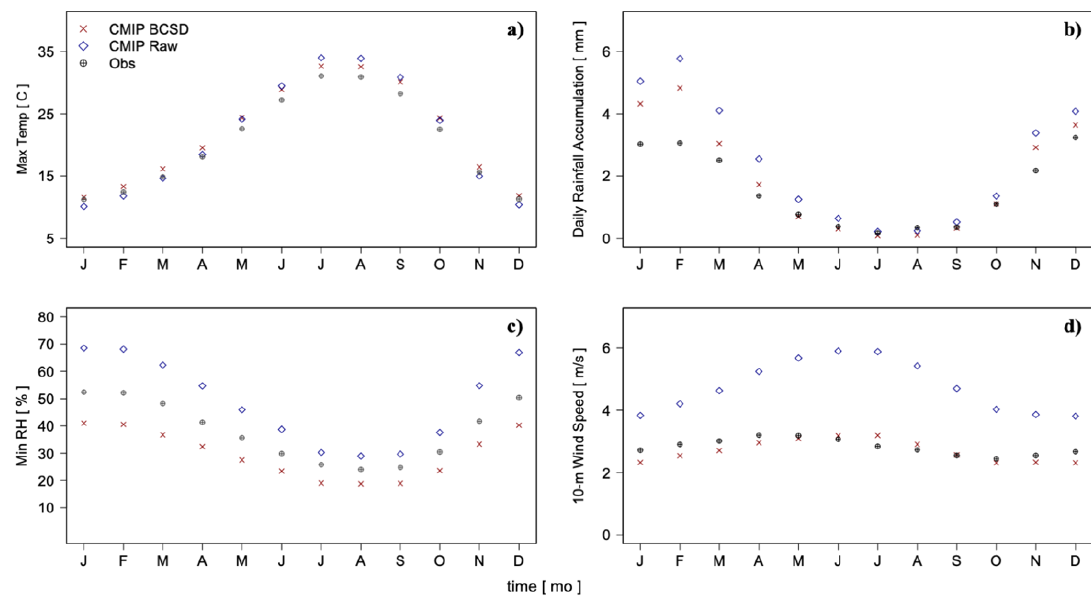
Figure 3. State-wide average monthly climatology (1979–2014) for the CMIP6 Raw and BCSD model ensembles. Observational data are an ensemble of NARR and TerraClimate. ( a ) Maximum temperature; ( b ) Daily Rainfall accumulation; ( c ) Minimum relative humidity; ( d ) 10 m wind speed.